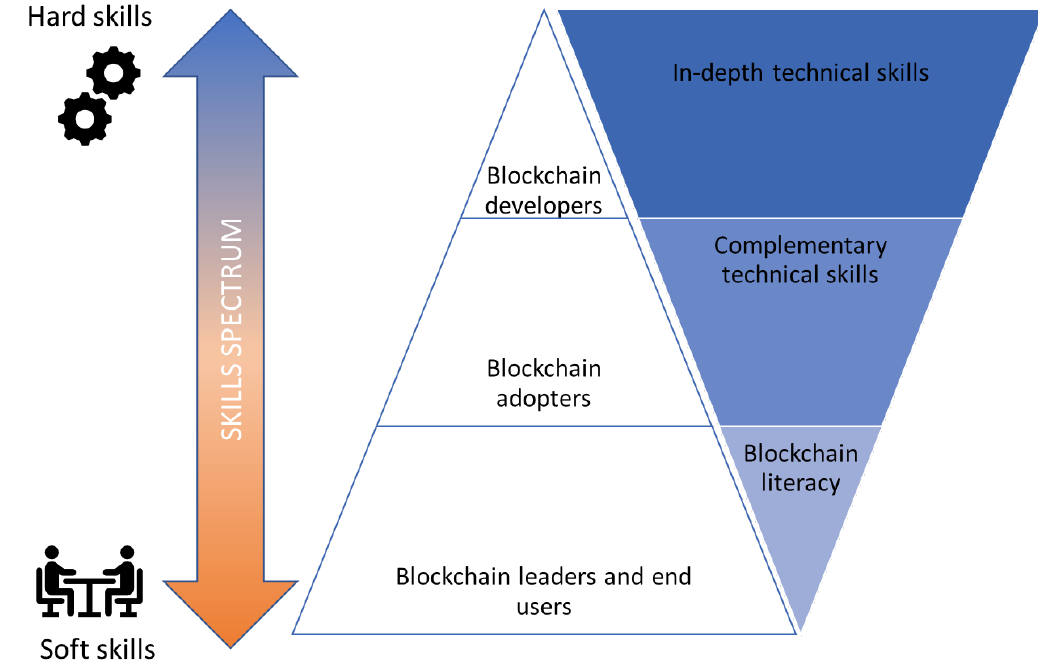
Figure 13. Hierarchy of blockchain technical skills for blockchain developers, adopters and